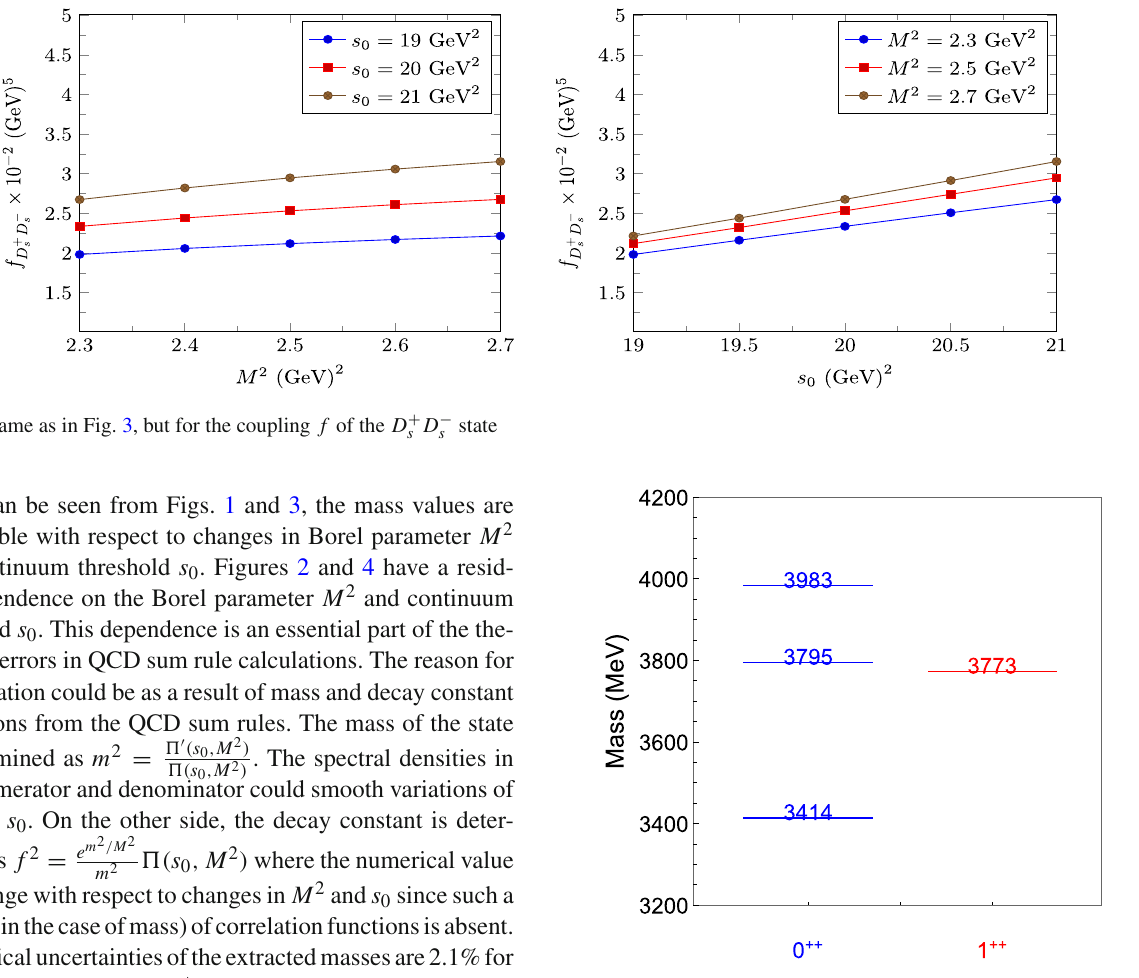
Fig. 5 Predicted mass values of D ¯ D and D + s D − s states, and the lowest χ ( 1 P ) state together with ψ( 3770 ) . The lowest state in J PC = 0 ++ c 0 is χ c 0 ( 1 P ) andthestatein J PC = 1 ++ is ψ( 3770 )